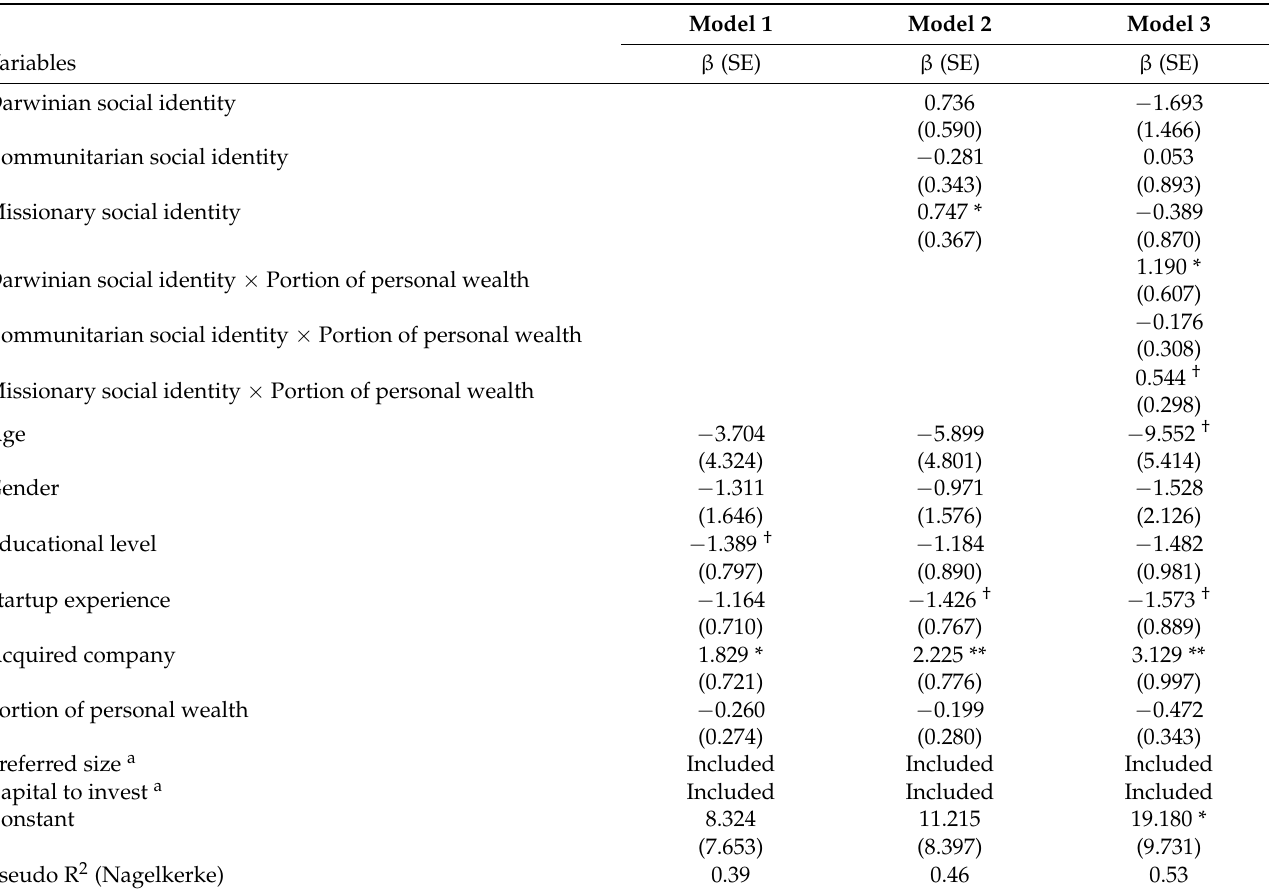
Figure 2. Interaction of portion of personal wealth and entrepreneurs’ Darwinian social identity for the desire to have full control. Note: With portion of personal wealth low = mean − S.D., and high = mean + S.D. 3. Materials and Methods 3.1. Sample and Data Collection Our sample consists of buyout entrepreneurs, which are individuals who are looking to become an entrepreneur by acquiring an existing venture, typically a small business (Wright et al. 2001a, 2001b). Buyout entrepreneurs are entrepreneurially motivated in the sense that their goal is to grow and enhance the business they acquire (Hunt and Fund 2012). They typically invest a large portion of their personal wealth in the venture they